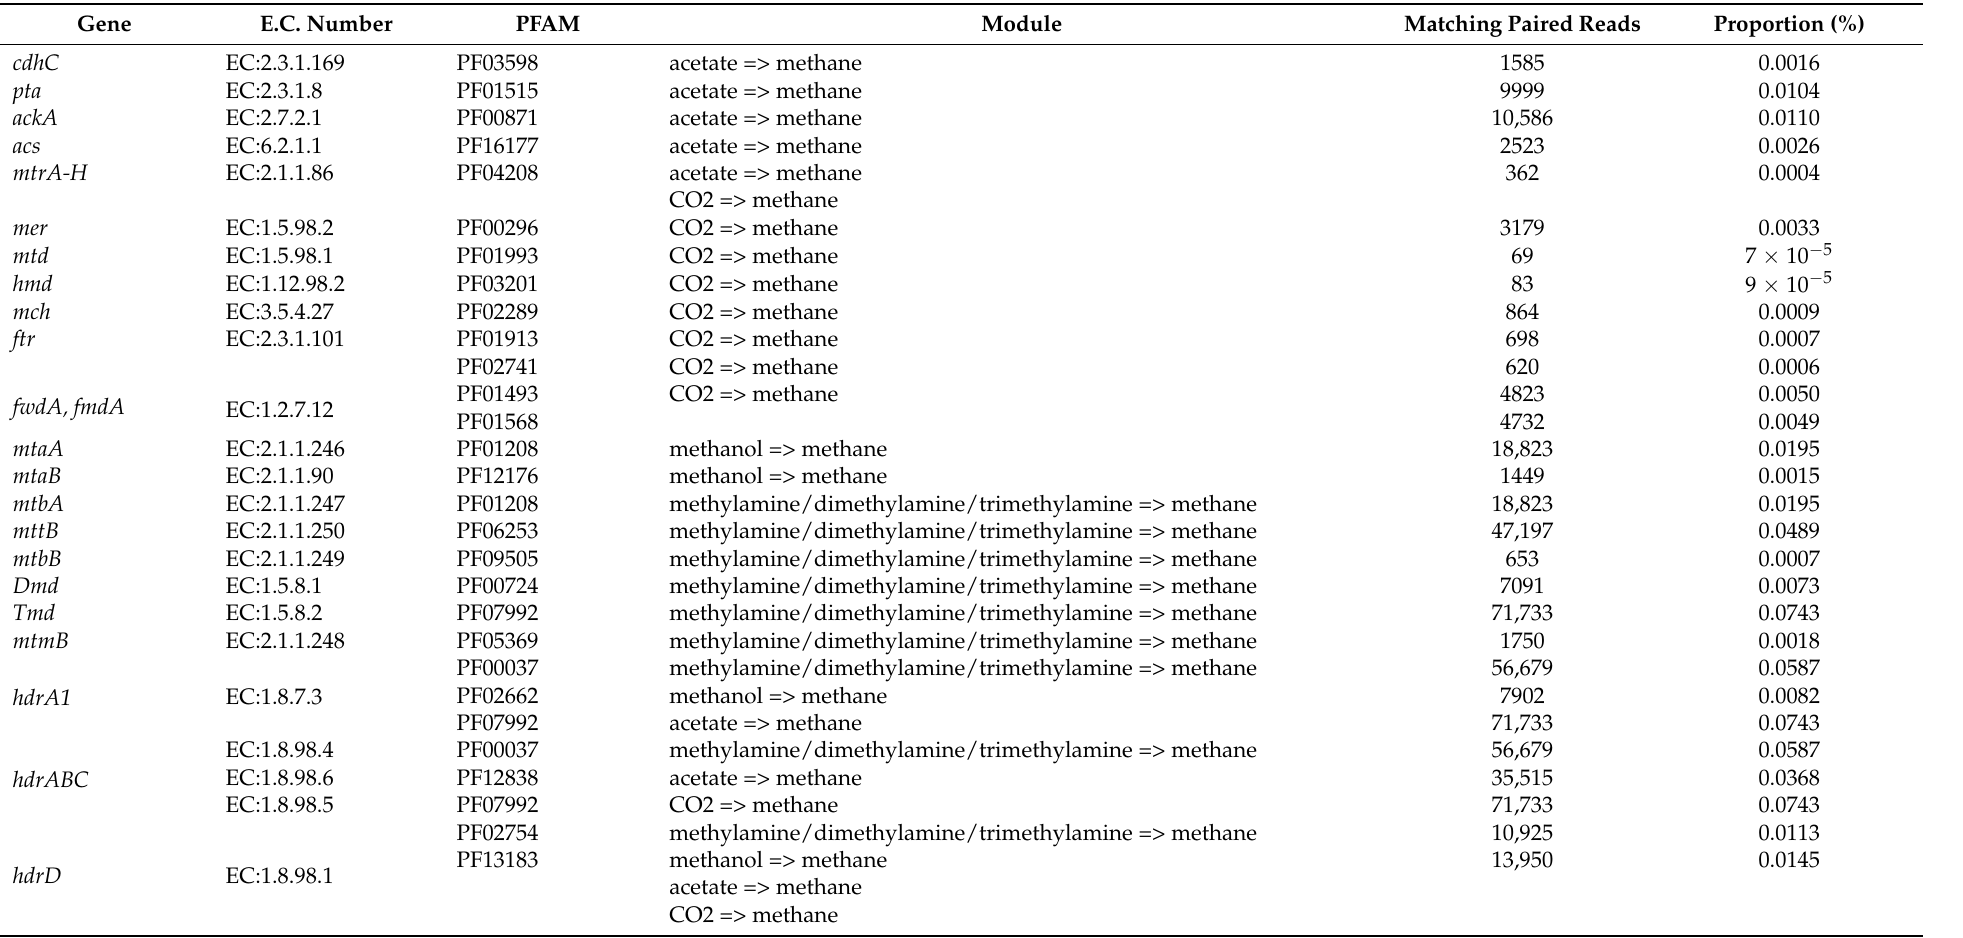
Table 2. Relevant genes related to the three metabolic pathways for methane generation, detected through the metagenomic analysis of the A5 sample. The right column corresponds to significant matches using the raw metagenomic reads (96,506,197 of paired reads